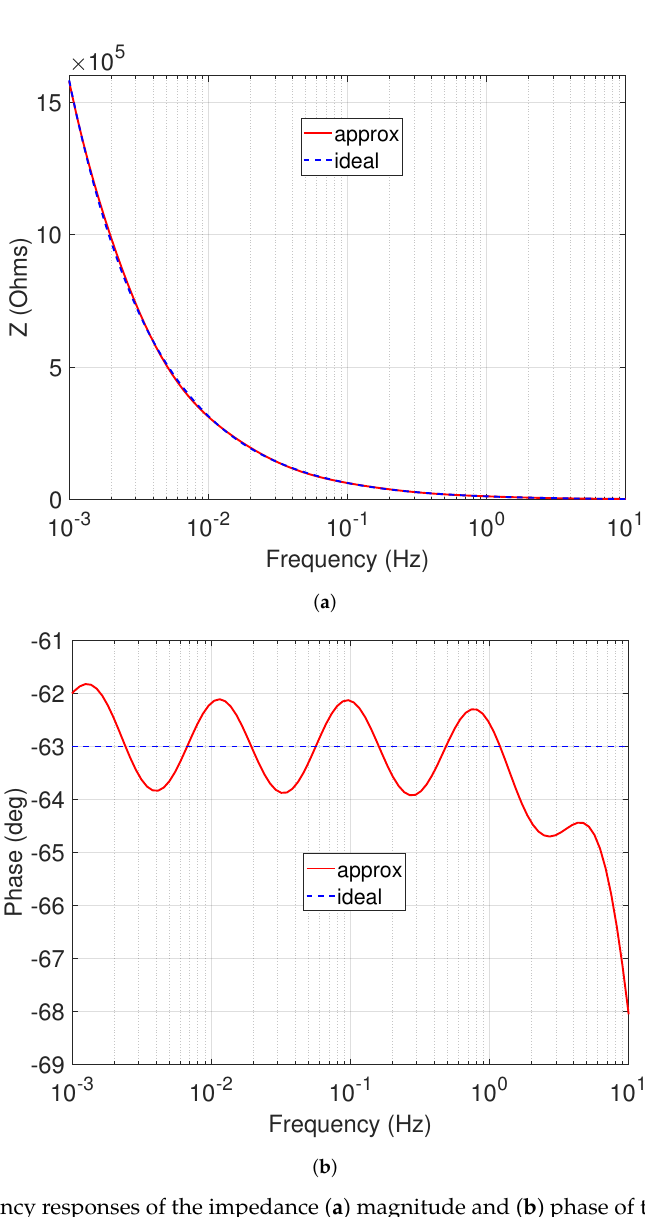
Figure 15. Frequency responses of the impedance ( a ) magnitude and ( b ) phase of the RC network in Figure 14 approximating a fractional capacitor with λ = 0.7 and C λ = 22 µ F/s 0.3 .